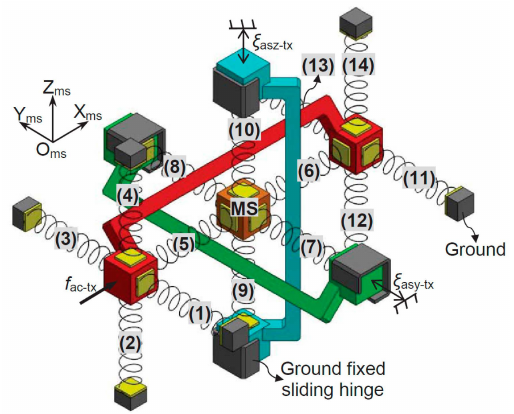
Figure 10. Demonstration of the rigid stages and FBCMs in the XYZ CPM system associated with only the X ms -axis translation (AS-Xs and their rigid linkage are red in color, AS-Ys and their rigid linkage are green in color, and AS-Zs and their rigid linkage are blue in